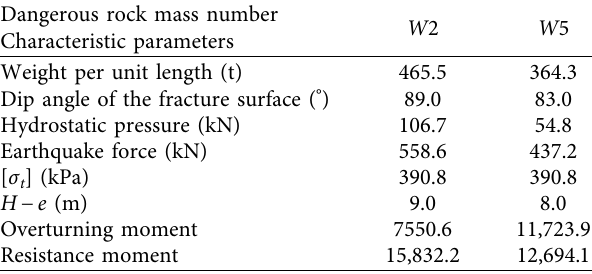
Table 5: Characteristic parameters of tipping-type dangerous rocks.